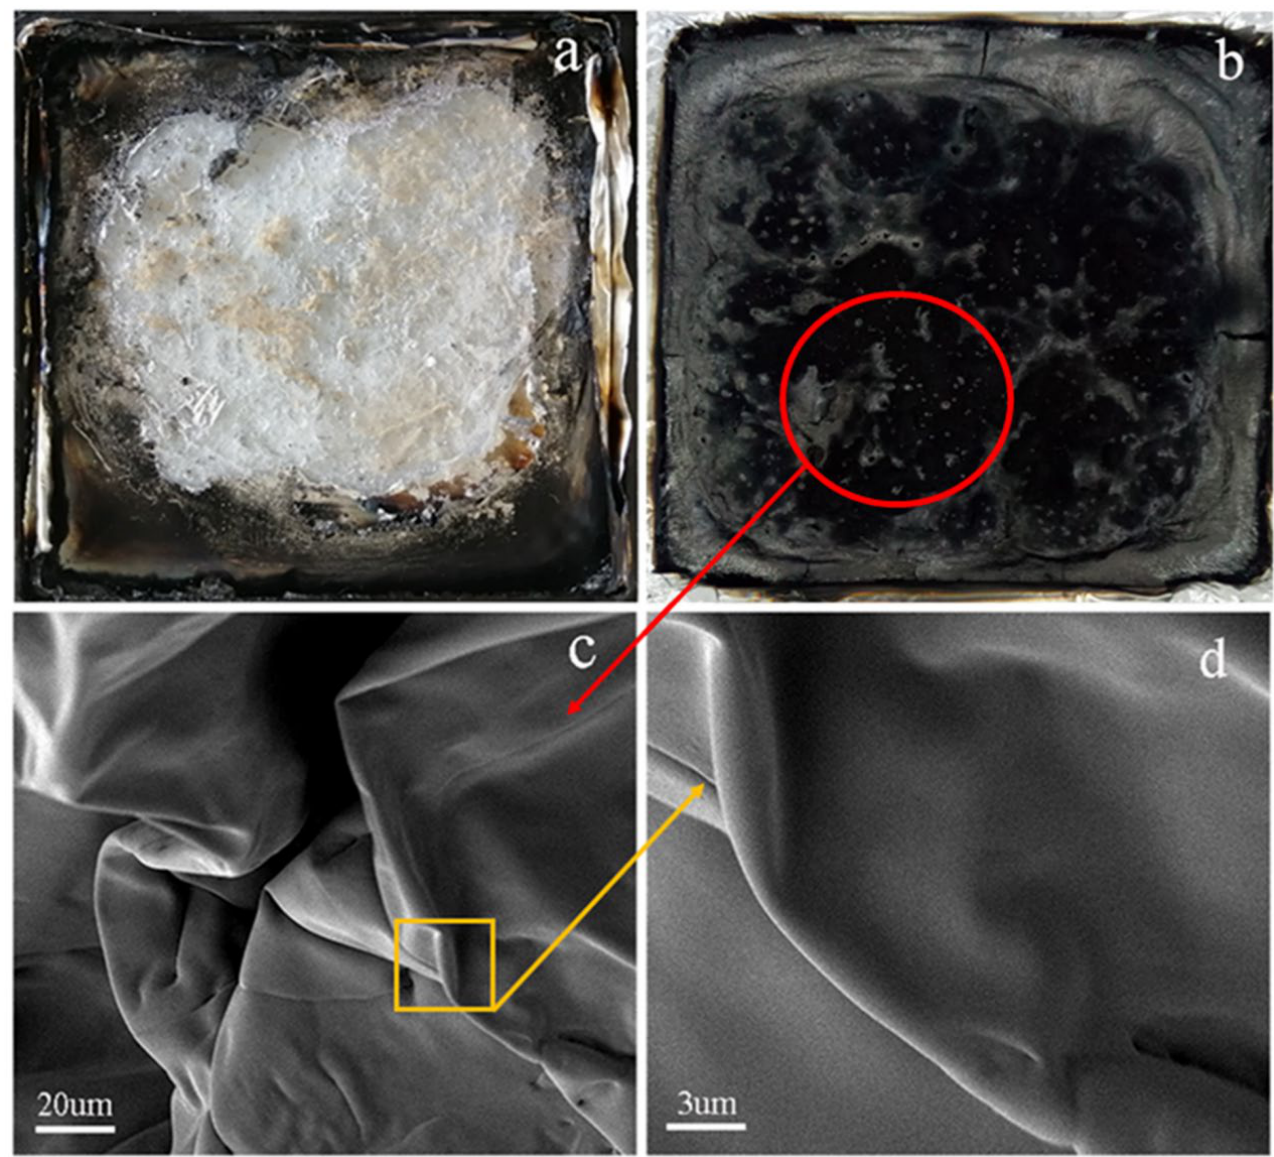
Figure 5. The pictures of residual char and SEM morphology. ( a ) the picture of pure PA66 after Cone calorimetry test; ( b ) the picture of FR–PA66 after Cone calorimetry test; ( c – d ) the SEM mophology images of FR–PA66; and red circle and yellow box: Zoom on the specified area.